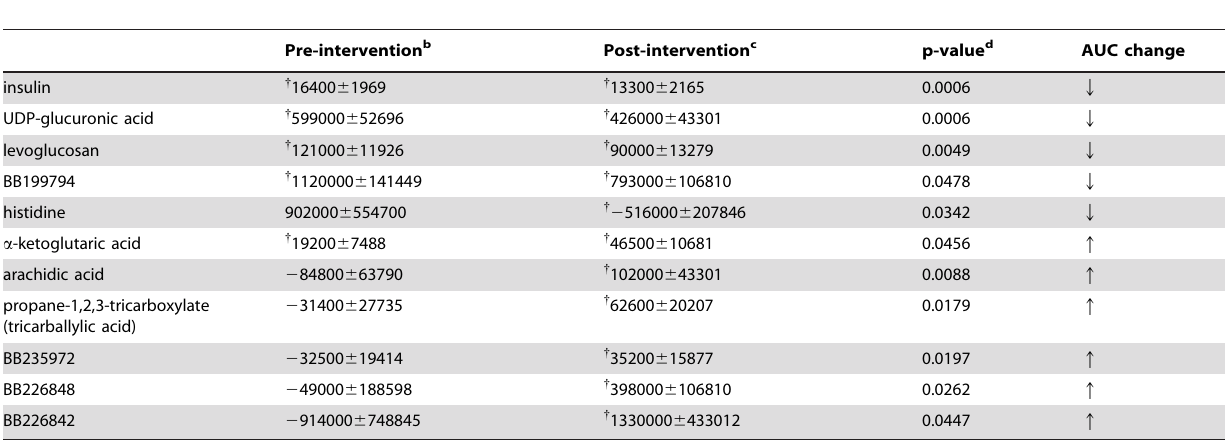
Table 3. Post-OGTT excursions (AUC) of plasma identified and as-yet unidentified metabolites a and serum insulin significantly changed by a weight loss and fitness intervention in adult